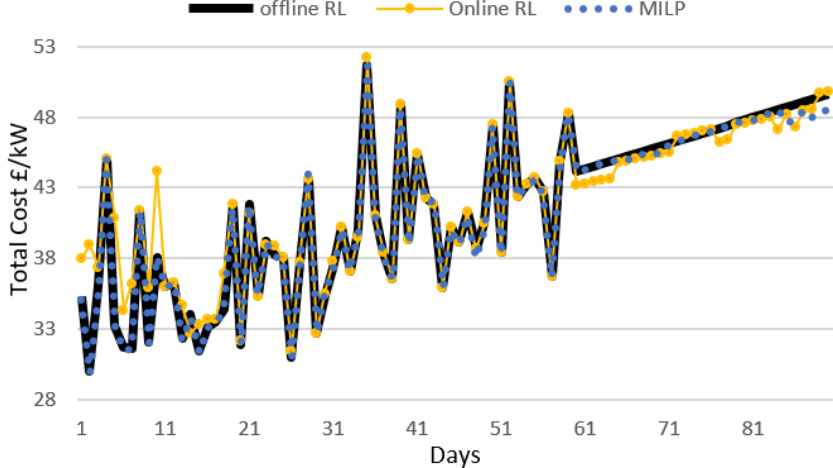
Figure 10. Performance of offline (ideal scenario) vs. online RL in terms of cost per day.